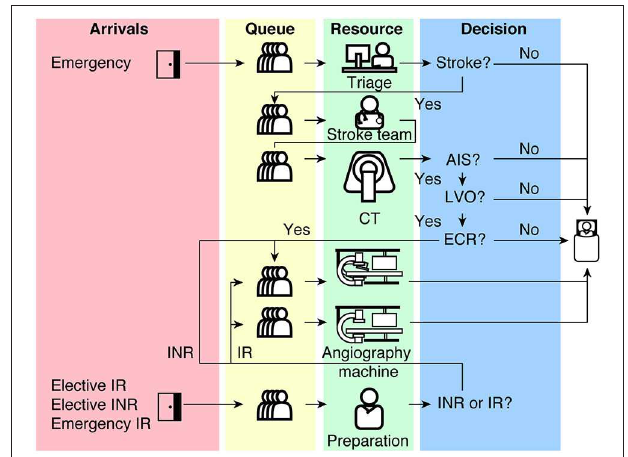
FIGURE 1 | A schematic diagram of our discrete event model of an ECR service from Emergency to angiography suite. CT, Computed Tomography; AIS, Acute Ischemic Stroke; LVO, Large Vessel Occlusion; ECR, Endovascular Clot Retrieval; IR, Interventional Radiology; INR, Interventional Neuroradiology.